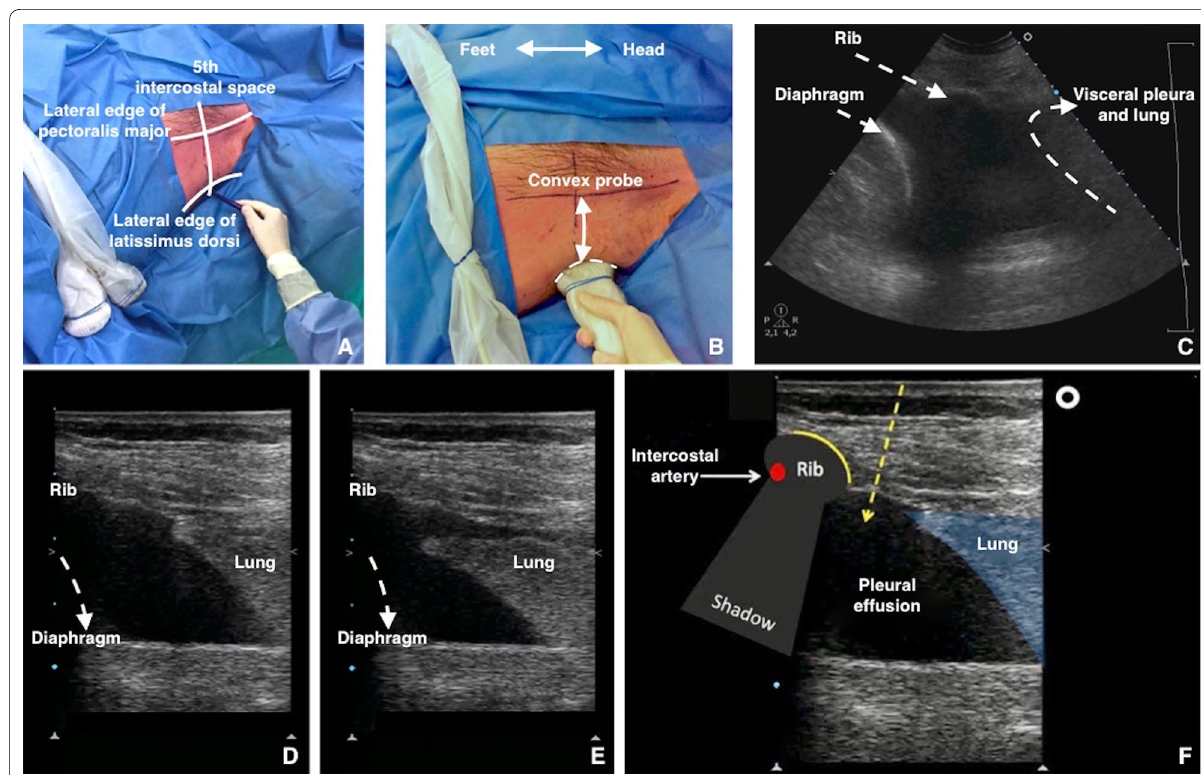
Fig. 3 A Identify and draw the safety triangle. Note both convex and linear probes are present. B , C Use a low-frequency US transducer (convex or phased array probe) to identify the best puncture site. The best puncture site is where the operator can visualise each anatomical structures (i.e., diaphragm, pleural, organs) and can measure the maximum distance between visceral and parietal pleural (increasing the safety margin). The probe should be used in the transverse position between two ribs. The probe marker is facing the patient’s head (on the right of the screen). D At the end-expiration (high-frequency US transducer) diaphragm reaches the most cranial position. E At the end inspiration (high-frequency US transducer) lung reaches the most caudal position. F A high-frequency US transducer (linear probe) should be used in the transverse position, between two ribs to understand the upper and lower border of the needle insertion area. The probe marker is facing the patient’s head (on the right of the screen). The operator designs the course of the needle within the expected insertion area